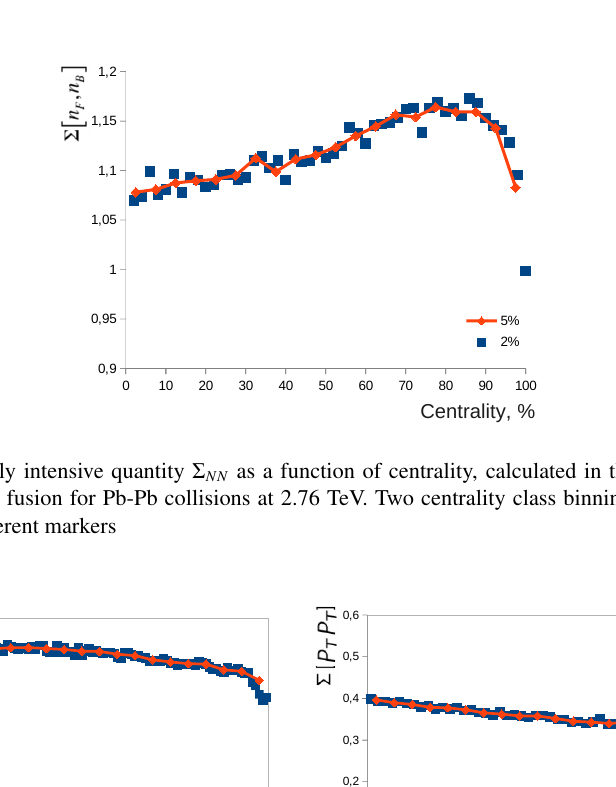
Centrality, % (left) and Σ P (right) as a function of centrality, calcu- T N T P T